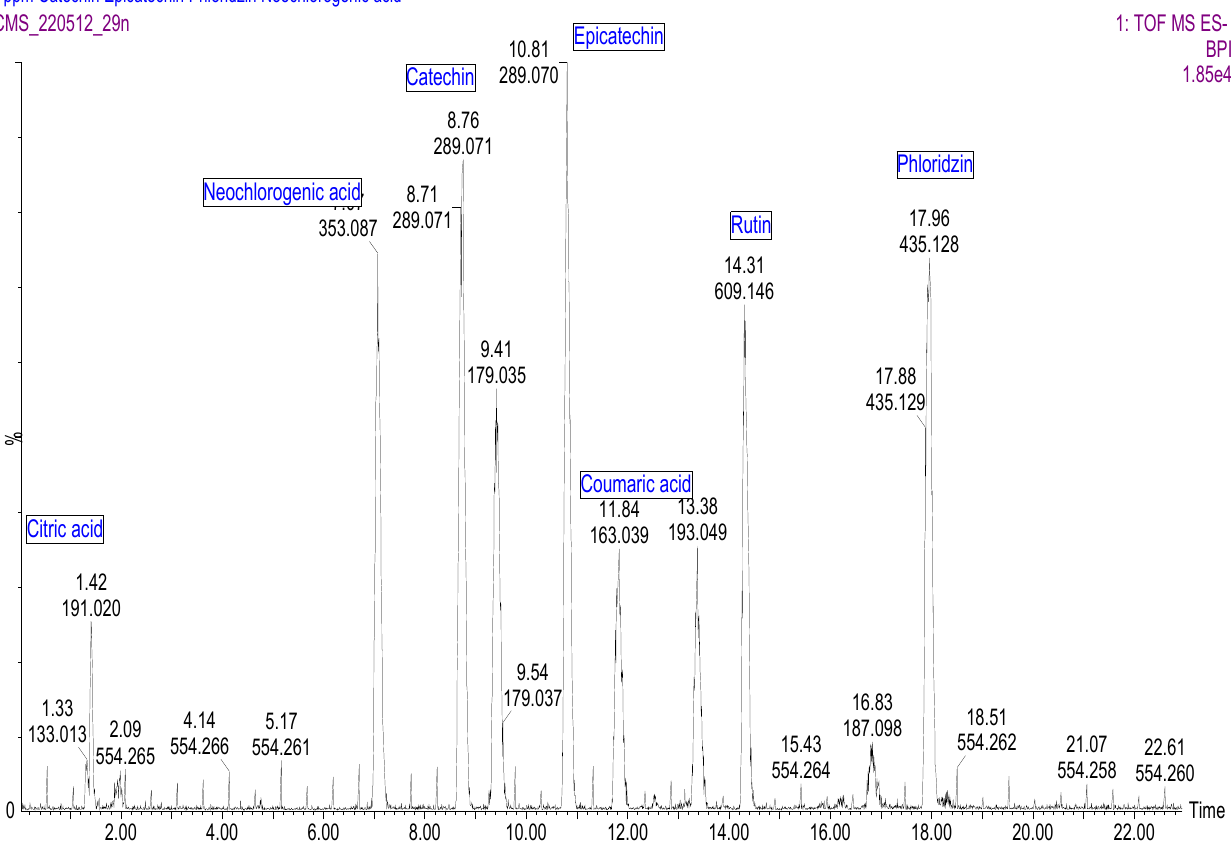
Figure 3. UHPLC-ESI-MS base peak chromatogram for the standard mix in the negative ion mode.